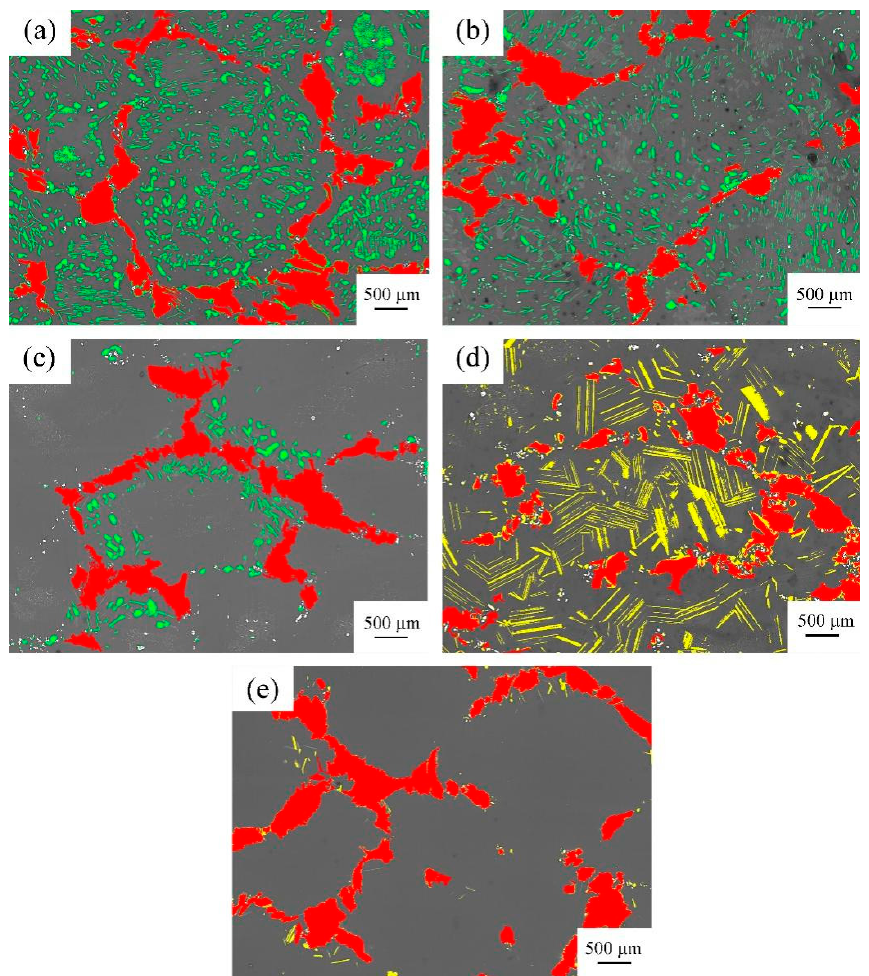
Figure 7. Statistical diagram of block phase, rare earth rich phase, rod phase, and lamellar phase volume fraction after different solution treatment by Image ‐ Pro ‐ Plus software: red is a block phase, green is a rod phase, yellow is a lamellar phase, and white is a rare earth ‐ rich phase. ( a ) 460 °C × 13 h, ( b ) 470 °C × 13 h, ( c ) 480 °C × 13 h, ( d ) 490 °C × 13 h, and ( e ) 500 °C × 13 h.